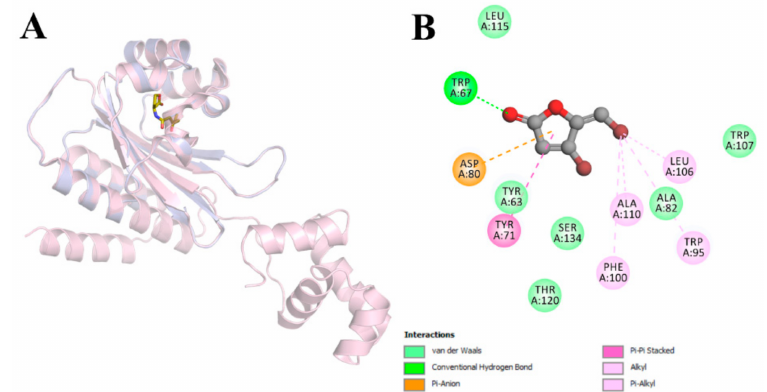
Figure 5. RhlR–ligand docking and interaction profiling. ( A ) Cartoon view of the superposed structures of the E. coli SdiA monomer (light pink; PDB identifier: 4Y15) and P. aeruginosa RhlR ligand-binding domain (light blue; homology model). The SdiA-bound exogenous ligand 3-oxo-C6-HSL is shown as gold sticks. This image was rendered by using the PyMOL Molecular Graphics System, v1.8 (Schrödinger LLC, Portland, OR, USA). ( B ) Favorable non-covalent interactions that are predicted to occur between furanone C-30 and RhlR. This figure was rendered by using Discovery Studio Visualizer, v16.1.0 (Dassault Syst è mes BIOVIA Corp., San Diego, CA,